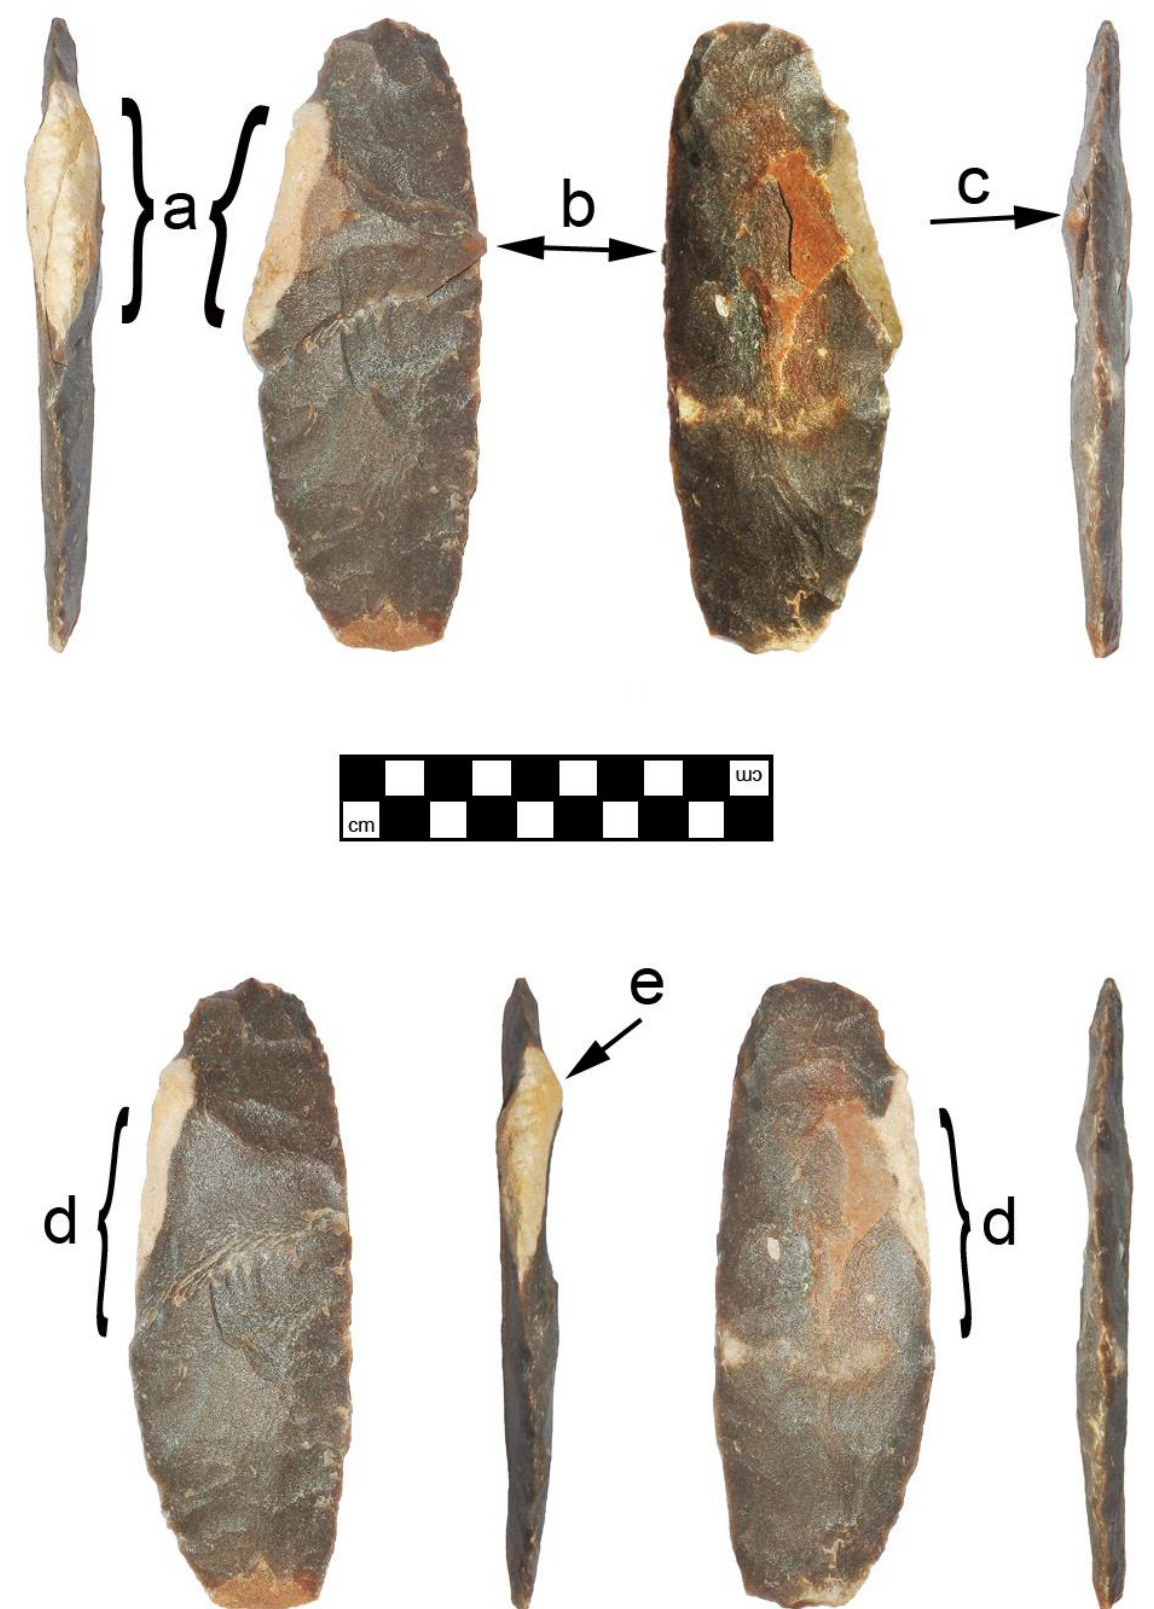
Figure 1. Replica Clovis middle phase biface with intentional successful overshot flake removal. A) cortex ’mass’ on biface margin; b) isolated platform; c) projected platform; d) area of margin removal; e) remaining cortex